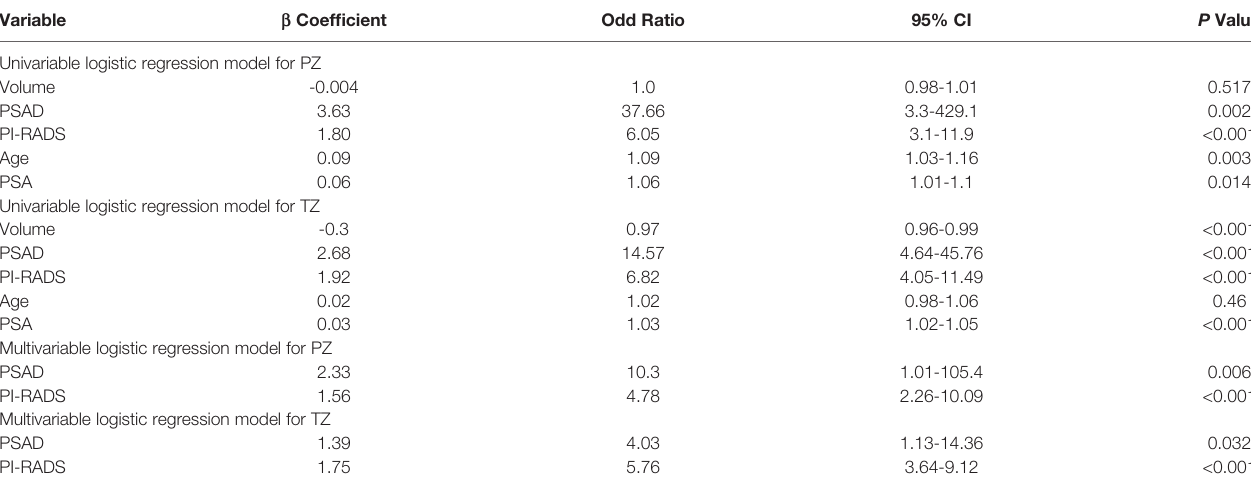
TABLE 3 | Univariate and multivariate logistic regression analyses. Logistic Regression